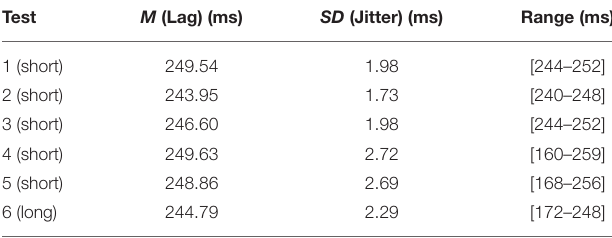
TABLE 2 | Timing test